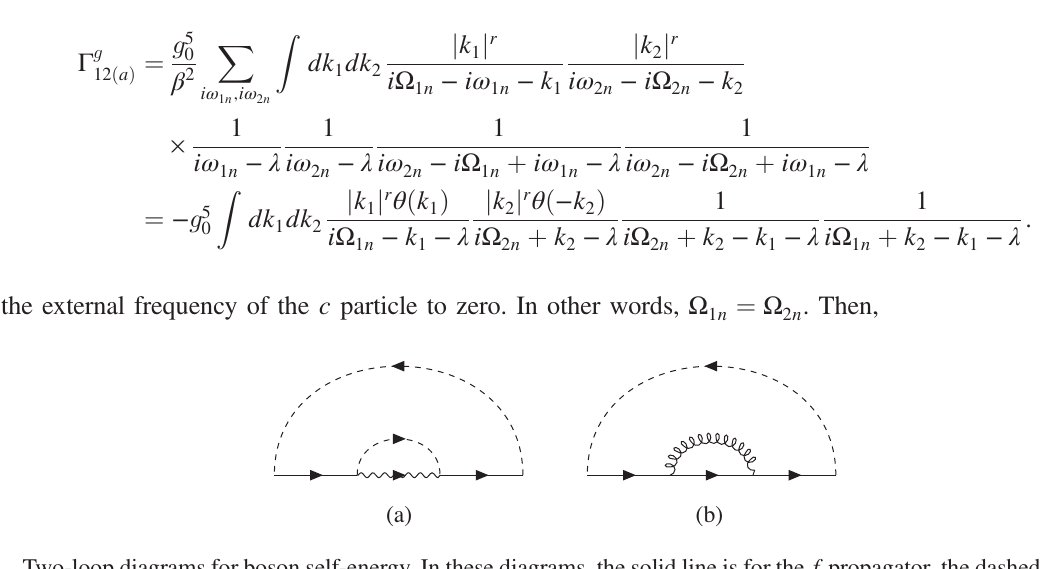
FIG. 11. Two-loop diagrams for boson self-energy. In these diagrams, the solid line is for the f propagator, the dashed line is for the ψ propagator, the wavy line is for the b propagator, and the spiral is for the ϕ